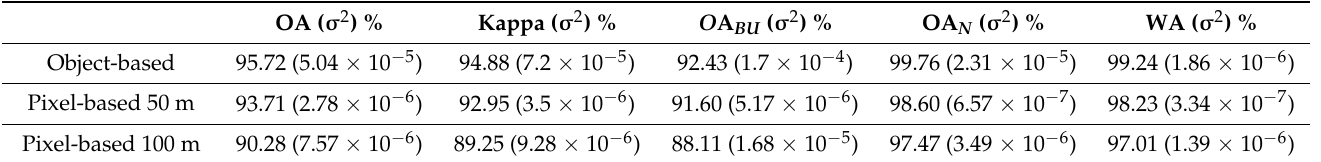
Figure 8. LCZ maps of three comparison schemes. ( A – C ) are the enlarged display areas for object- based, pixel-based in 50 m and pixel-based 100 m respectively. Table 9. Accuracy assessment results for three schemes with the average values from 50 runs for each scheme.